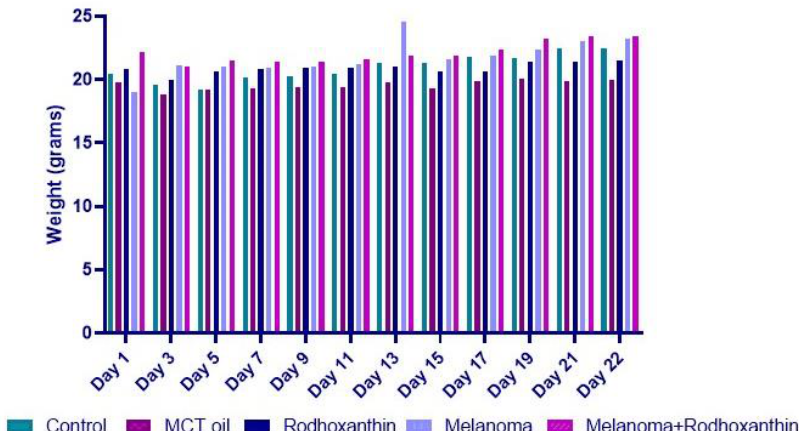
Figure 1. The weight variation of individuals included in the study (Control: received (PBS) 0.9%, sc.; MCT oil: 100 µL of MCT oil, orally administered, for 21 days; Rhodoxanthin: received 100 µL of MCT oil/day, orally, for 21 days; Melanoma: inoculated with 1 × 10 6 B16F10 cells/100 µL PBS/mouse; Melanoma + Rhodoxanthin: inoculated with 1 × 10 6 B16F10 cells/100 µL PBS/mouse and received 100 µL of MCT oil/day, orally, for 21 days containing the according dosage of rhodoxanthin for each mouse).